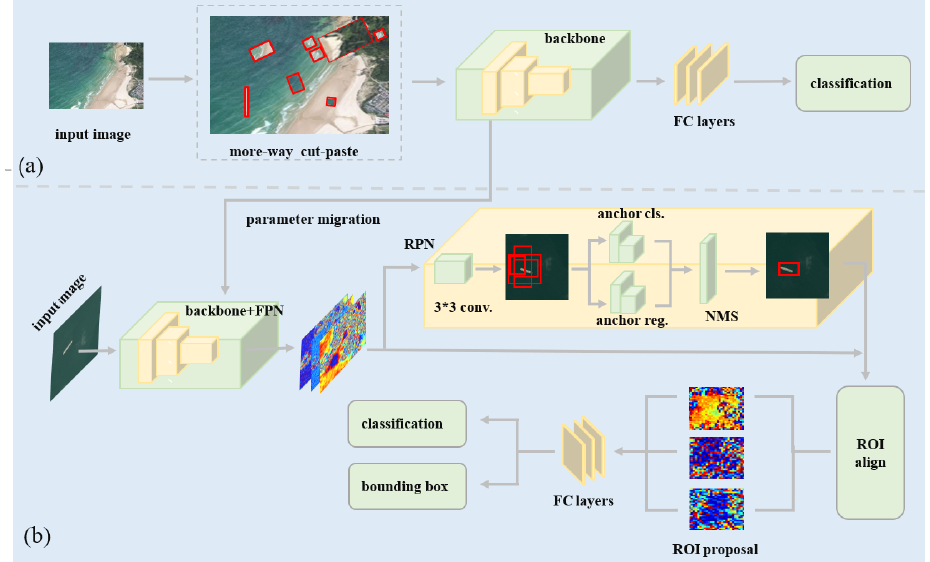
Figure 1. Illustration of the designed self-supervised-based object detection network SS R-CNN. ( a ) Self-supervised learning module. The network is trained by a more-way CutPaste classification task on images with no target objects. ( b ) Object detection module. The representation network migrates from the self-supervised learning module to a modified Mask R-CNN network that generates dense candidate anchor frames through the RPN network and determines the final detection box by the ROI align